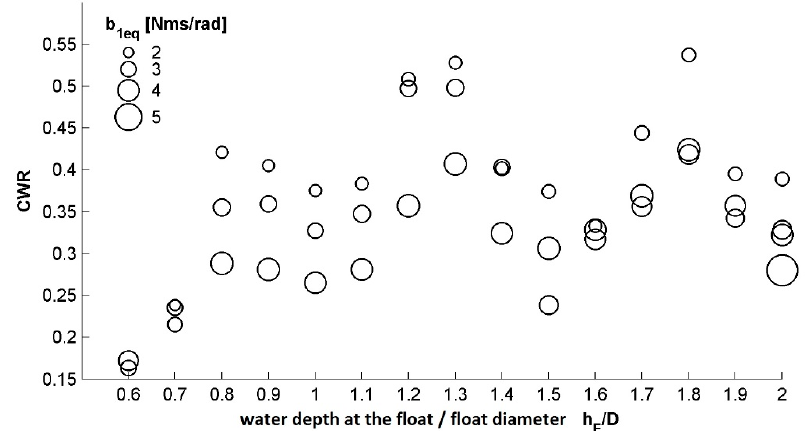
Figure 6. CWR of the float-only system as a function of float damping b 1eq , water depth at the float h F /D . Wave A.